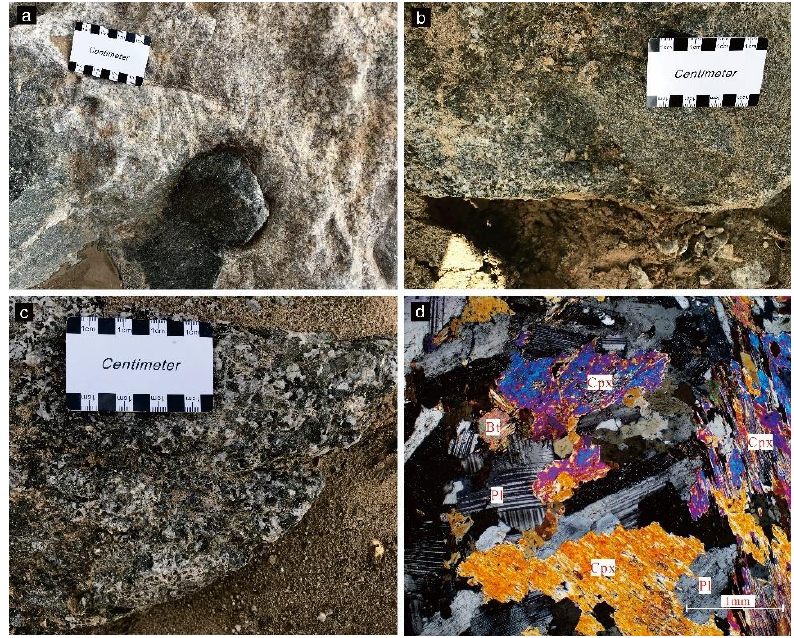
Figure 3. Outcrops and photomicrographs of Early Silurian Yuejingshan gabbro in the EKOB. ( a ) The boundary with the surrounding rock mostly follows an undulation curve. ( b ) The rocks at the contact boundary show a medium-fine grain texture. ( c ) The rocks inside have a coarse grain texture. ( d ) Photomicrograph of gabbro (cross-polarized light). Abbreviations: Cpx, clinopyroxene; Bt, biotite; Pl, plagioclase.